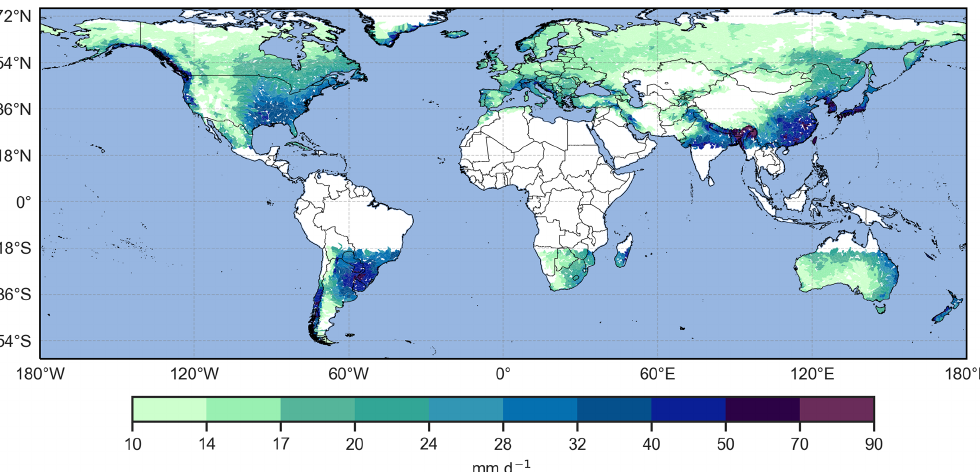
Figure 2. The 99th annual percentile of daily precipitation per catchment (mmd − 1 ). White areas correspond to the catchments that have been excluded from the